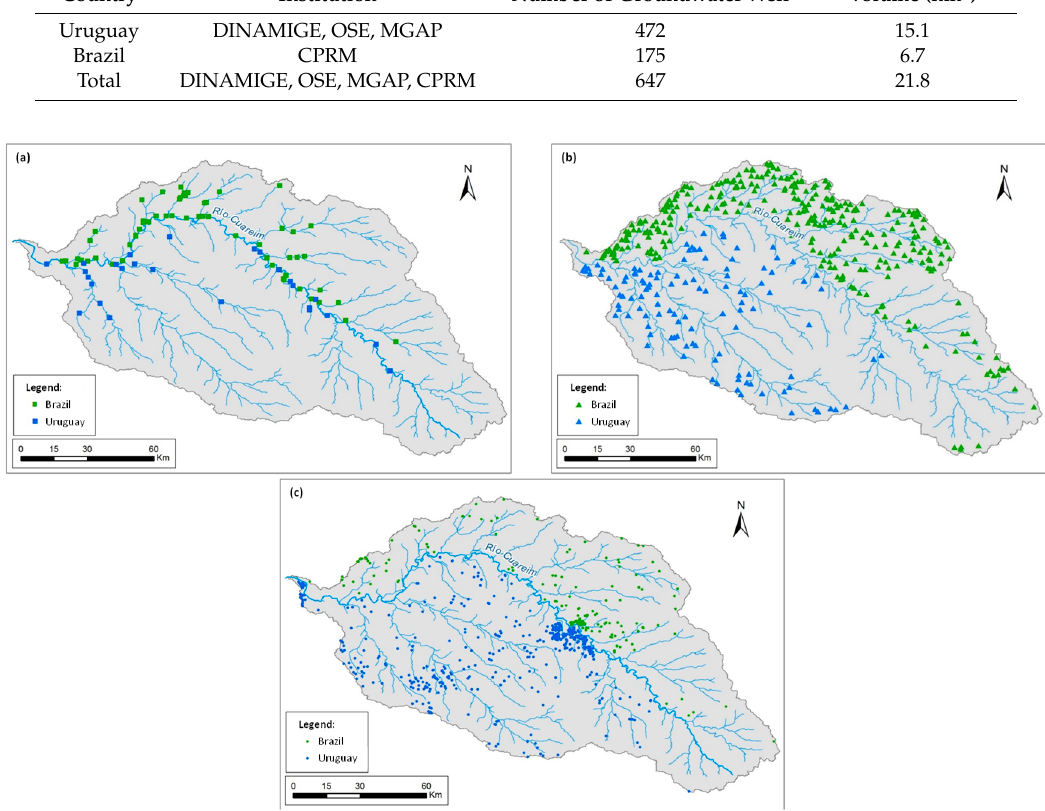
Figure 5. Location of ( a ) direct water intakes ( b ) small reservoirs, and ( c ) groundwater extraction wells in the Cuareim/Quaraí watershed.